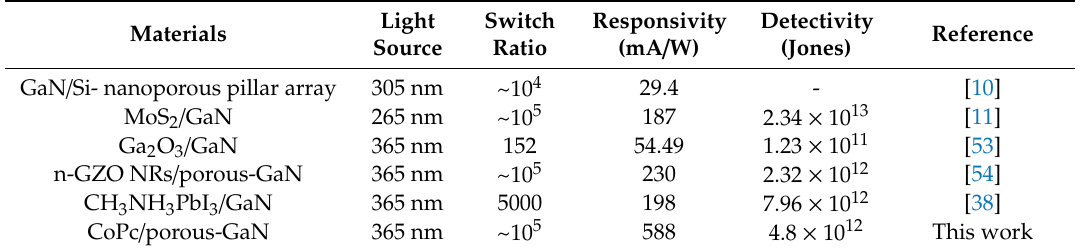
Table 1. Performance comparison between di ff erent self-powered GaN-based UV